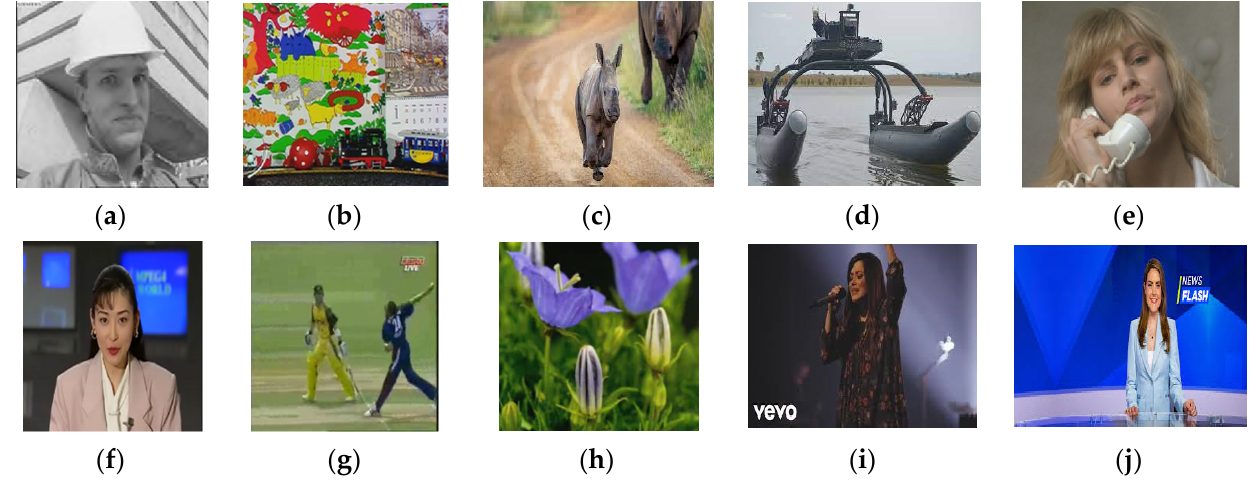
Figure 7. Sample frames of test video sequences used for simulation of the proposed ADS algorithm and other state-of-the-art and well-known motion estimation algorithms: ( a ) Foreman, ( b ) Mobile, ( c ) Rhinos, ( d ) Robot boat, ( e ) Suzie, ( f ) Akiyo, ( g ) Cricket, ( h ) Flower, ( i ) Kari-Jobe, ( j ) News Flash.